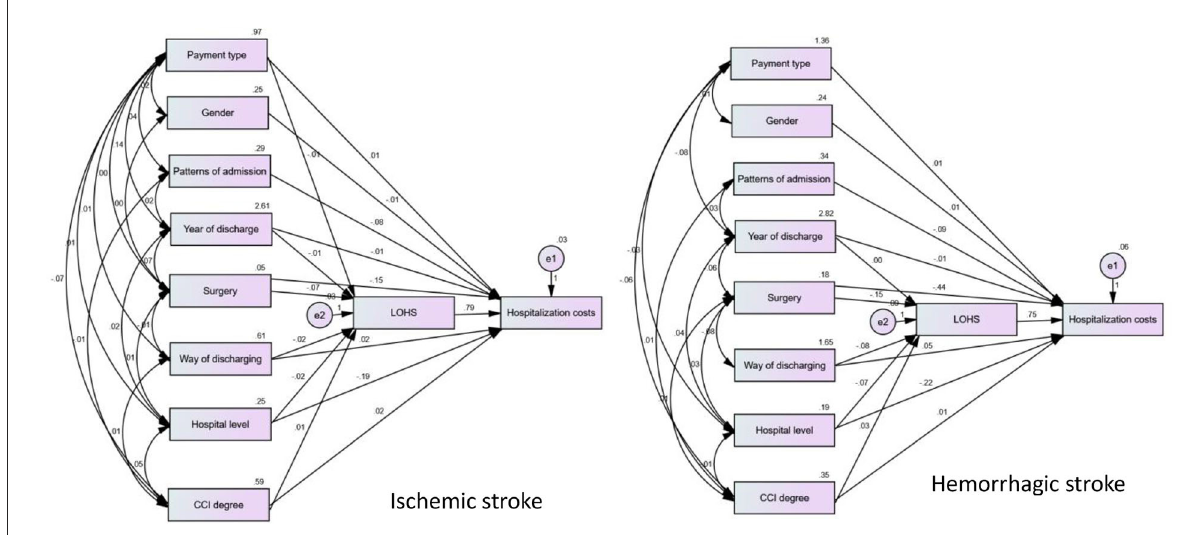
FIGURE2 Structural equation model of influencing factors of hospitalization costs in patients with ischemic and hemorrhagic stroke.